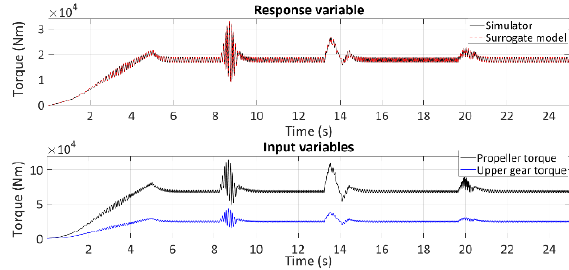
Figure 4: The values of model variables including the estimates from the surrogate model.